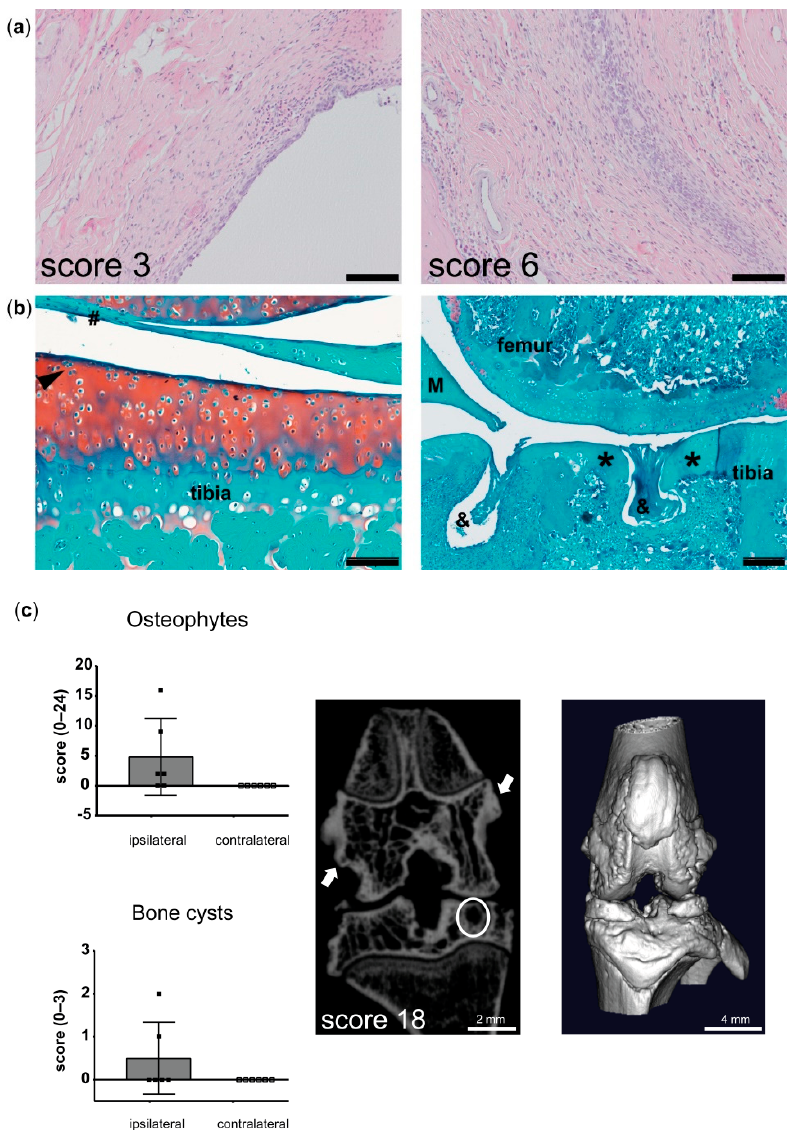
Figure 2. Osteoarthritis (OA)-related features in joints from rats in the modified arthritis model. ( a ) Left; microscopic image of the best outcome of Krenn score, reflecting mild synovitis (3 out of 9), right; microscopic image of the worst outcome of Krenn score, showing moderate–severe synovitis (6 out of 9). Scale bars = 100 µm. ( b ) Left; microscopic image of the best outcome of Mankin score, reflecting very mild cartilage degeneration, hashtag indicates pannus formation, black arrow shows cell cloning. Scale bar = 100 µm. Right; microscopic image of the worst outcome of Mankin score. Asterisk indicates loss of proteoglycans and hypo-cellularity. Ampersand shows bone erosion. M = meniscus. Scale bar = 20 µm. ( c ) Left; quantification of osteophyte and bone cyst formations in the affected ipsilateral and contralateral knee joints of untreated animals that were reactivated with peptidoglycan polysaccharide (PGPS). Data represent mean ± standard deviation (SD). Right; 2D and 3D µCT image of the affected joint from an untreated rat. Arrows indicate osteophytes and a bone cyst in the tibia plateau is encircled.